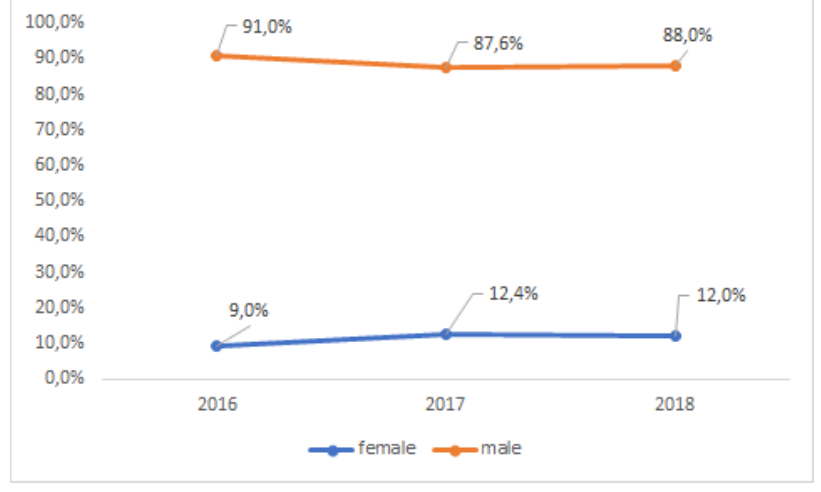
Figure 4. GSoC participants gender from 2016 to 2018 [48].